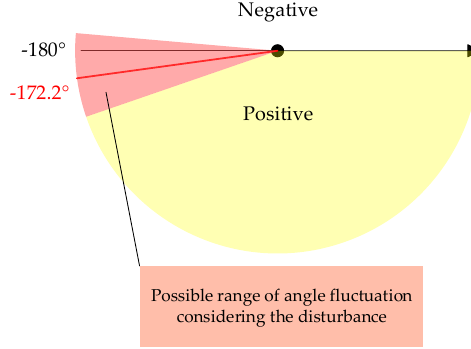
Figure 11. The calculated angle of the directional relay based on the PSFC.